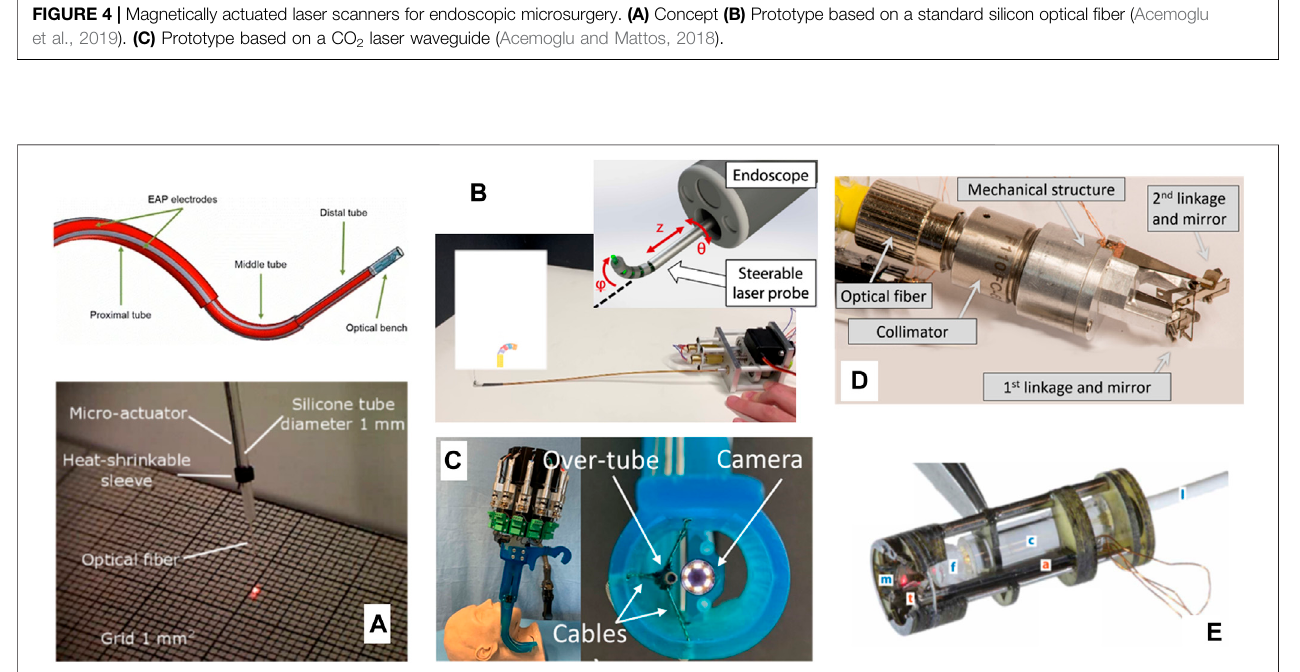
FIGURE 5 | Further laser steering devices for endoscopic surgery. (A) A biocompatible conducting polymer continuum robot (Chikhaoui et al., 2018) (B) A fl exible steerableinstrument(O ’ Brienetal.,2019). (C) Acable-drivenparallelroboticsystem(Zhaoetal.,2020). (D) Amillimeter-scaletip/tiltlaser-steeringsystem(Bothneretal., 2019). (E) Microrobotic laser steering system (York et al.,